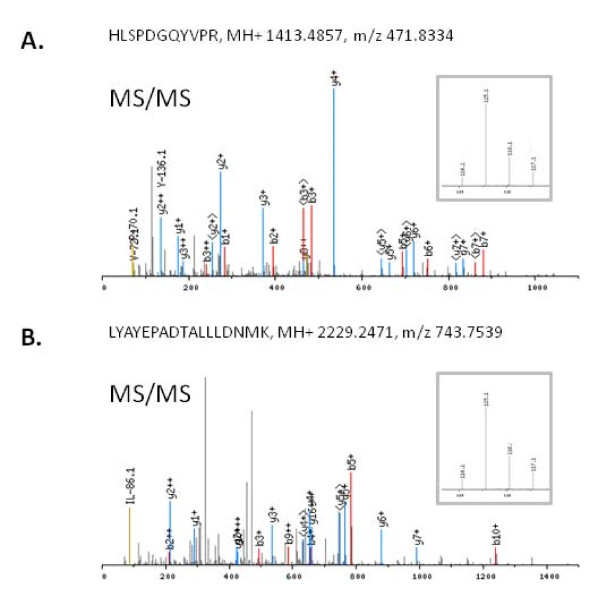
Identification and quantification of AGR2 in pancreatic juice by iTRAQ labeling and tandem mass spectrometry. Two unique peptides (HLSPDGQYVPR and LYAYEPADTALLLDNMK) from AGR2 were identified; the MS/MS spectra are presented in panel A and panel B respectively. The inserts are the iTRAQ reporting peaks at 114, 115, 116 and 117 representing relative intensity of the 4 samples compared: 114, pooled normal control juices; 115-117 were from PanIN case a, case b and case c respectively.